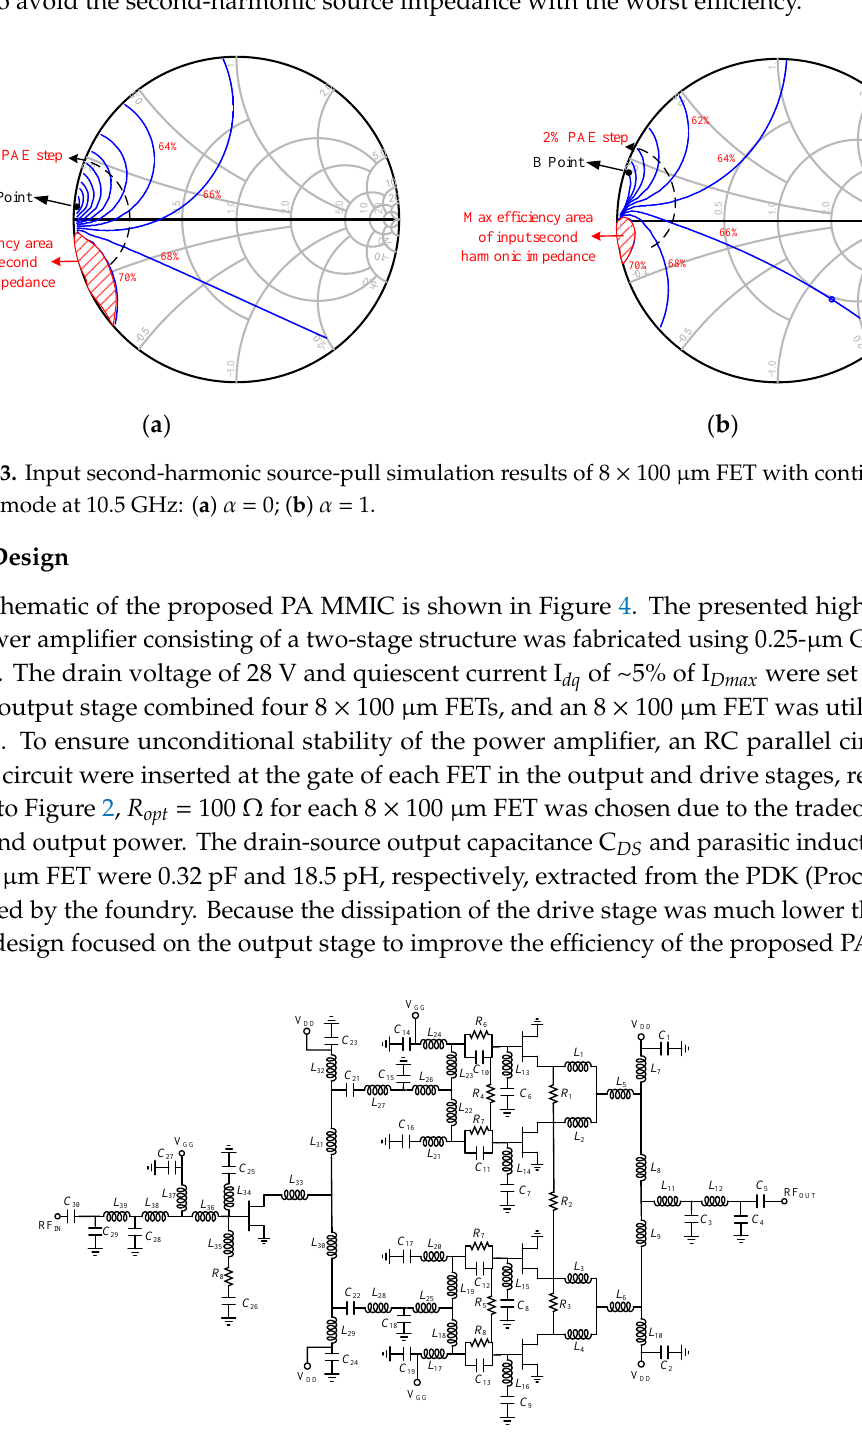
( b ) Figure 5. ( a ) The schematic of the output matching network; ( b ) the responses of second-harmonic load impedance versus L 04 and C 01